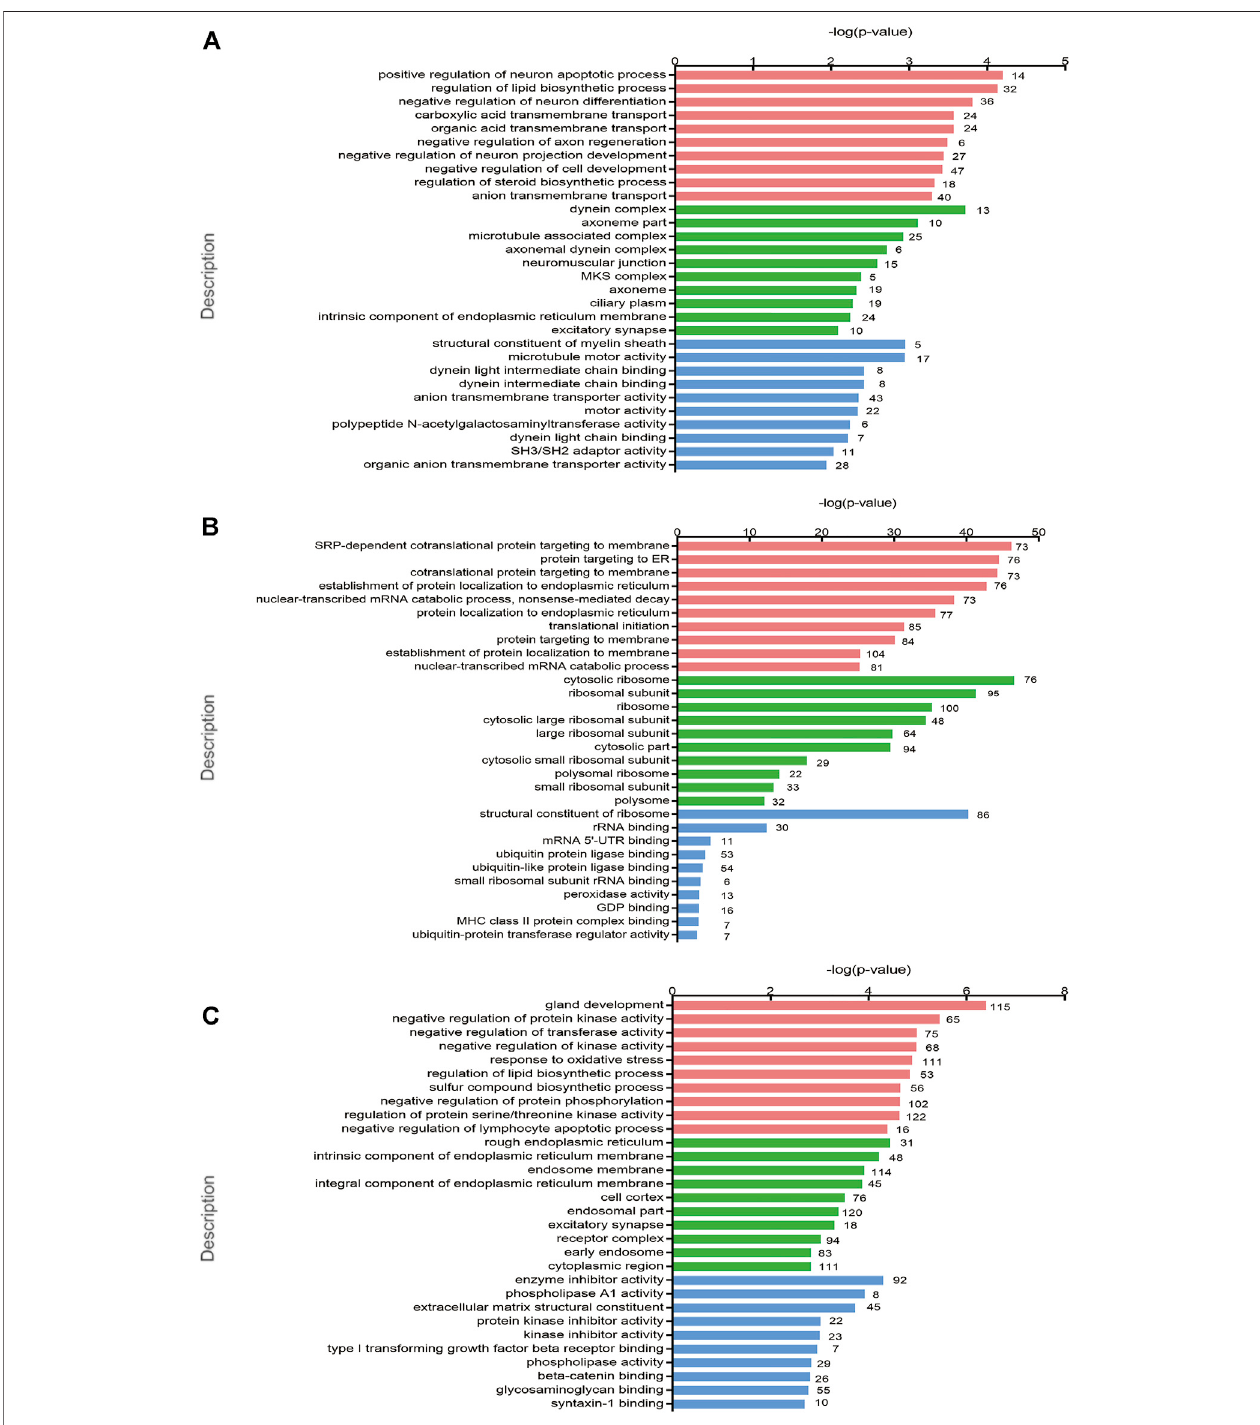
FIGURE 2 | GO and KEGG pathway enrichment analyses of the differentially expressed genes. (A – C) Top 10 GO terms of gene enrichment analysis in PCOS versus control, normoweight PCOS versus normoweight control, and overweight/obese PCOS versus overweight/obese control in three main categories. The red columns indicate the biological process category, the green columns indicate the cellular component category, and the blue columns indicate the molecular function category.